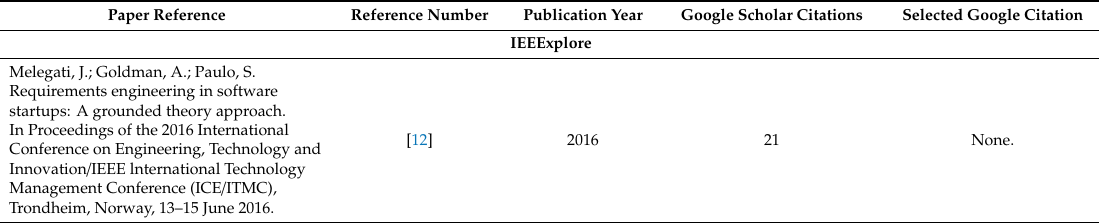
Table 2. Studies extracted for